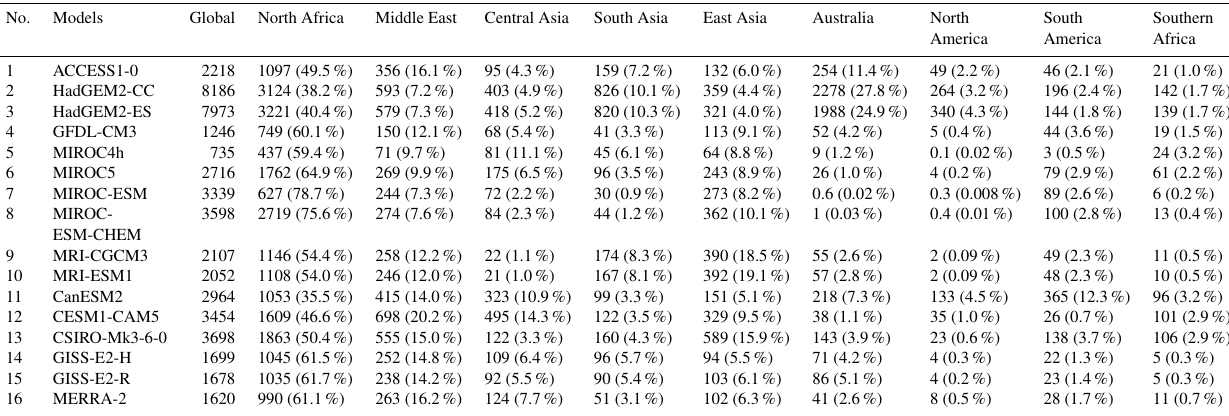
Table 4. Dust emission amount (Tg) in nine dust source regions. The contribution of each source region to global total dust emission is given in the parentheses next to the dust emission amount.